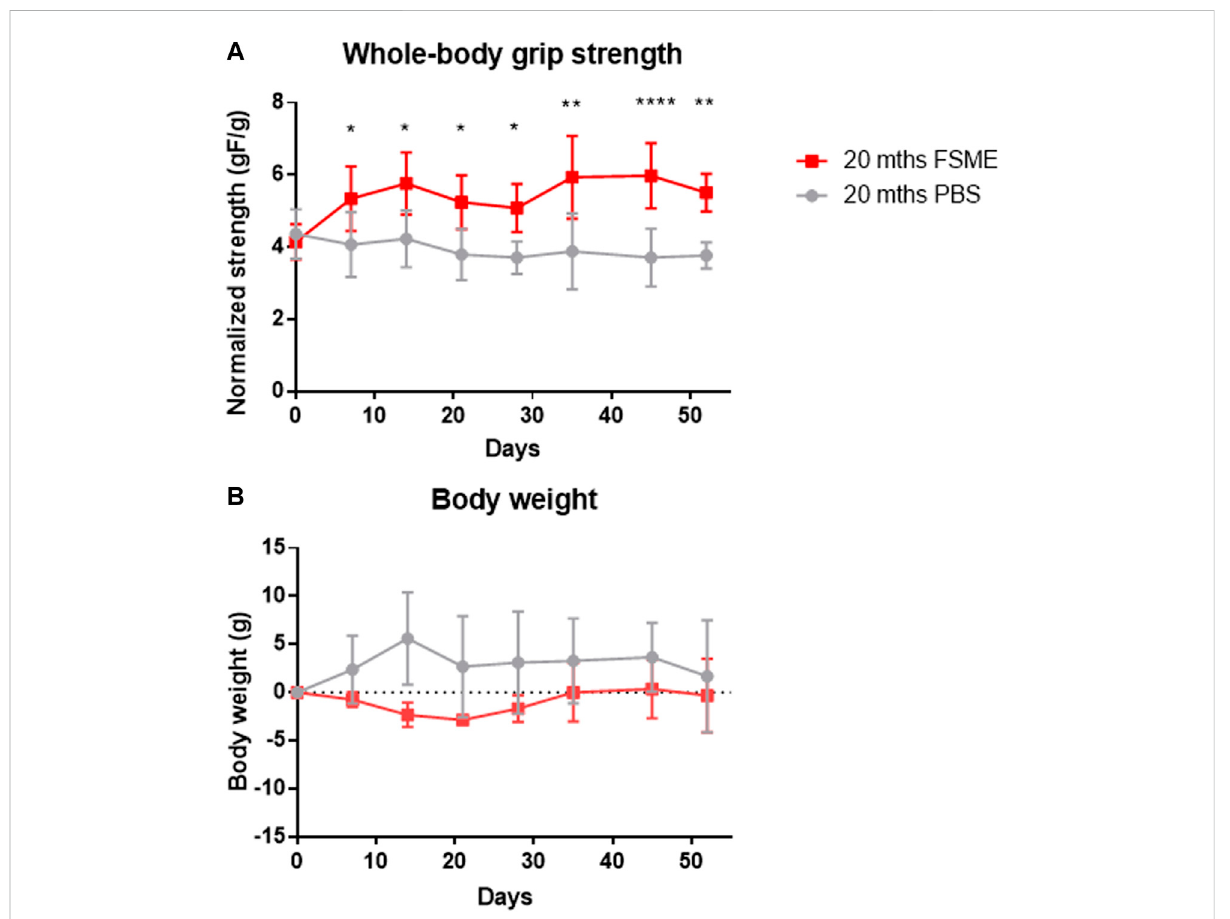
FIGURE 5 (A) Grip strength analysis of 20-month-old mice after FSME treatment for 8 weeks. FSME (30 mg/kg) administration is able to improve grip strength in FSME mice. (B) Body weight has shown no difference between the FSME group and PBS groups. Data are presented as mean ± SD, * represents p < 0.05, ** represents p < 0.01, and **** represents p < 0.0001 by the multiple t -test and Holm Sidak post hoc